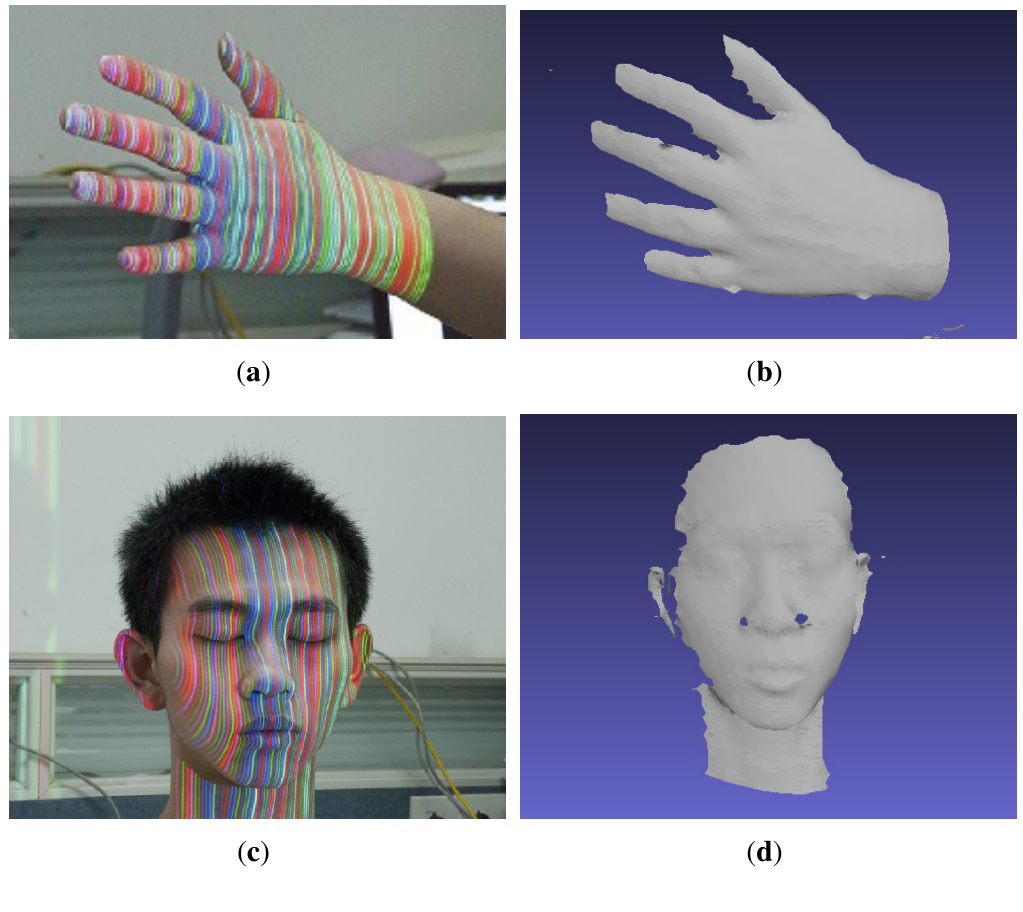
Figure 3. Reconstruction examples: ( a ) hand; ( c ) face and ( e ) hand with background of hexahedron under the pattern illumination. Reconstructed surface of the ( b ) hand; ( d ) face and ( f ) hand with background of